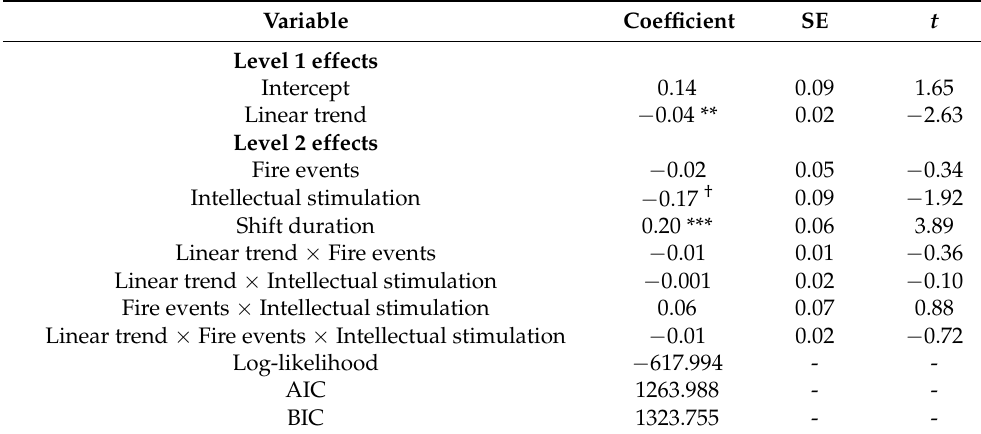
Table A10. Fire Events and Intellectual Stimulation Predicting Change in Emotional